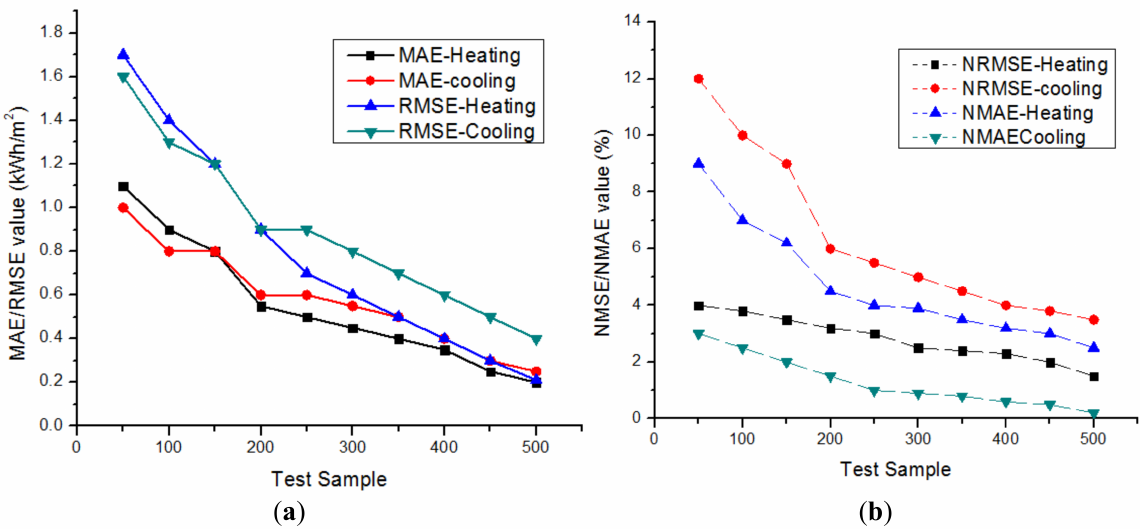
Figure 7. Analysis of the best performing model in terms of prediction using the MSE metric. ( a ) Heating load, ( b ) cooling load.